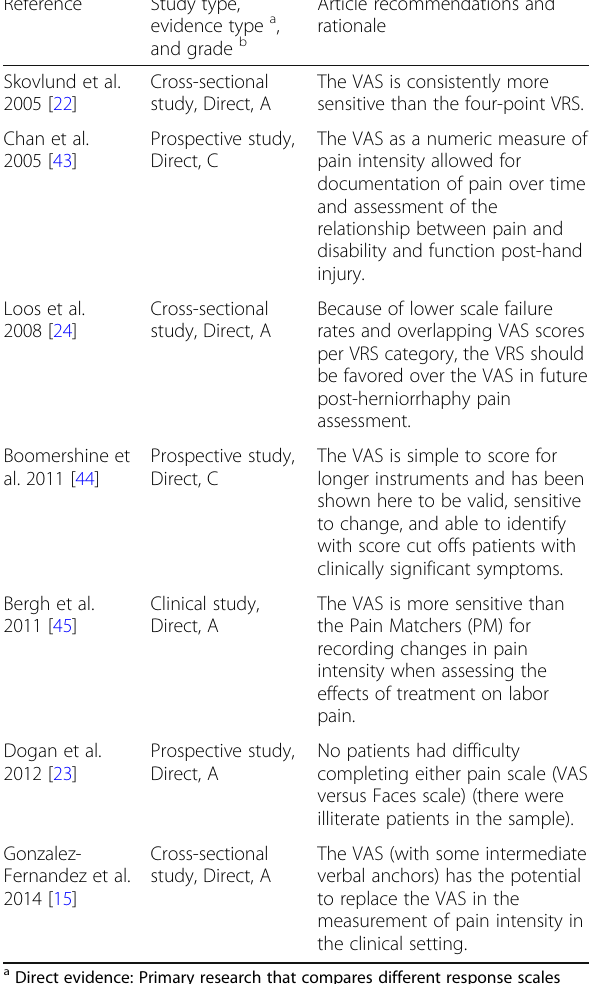
Table 3 Summary of key evidence to support the visual analog scale (VAS) in pain